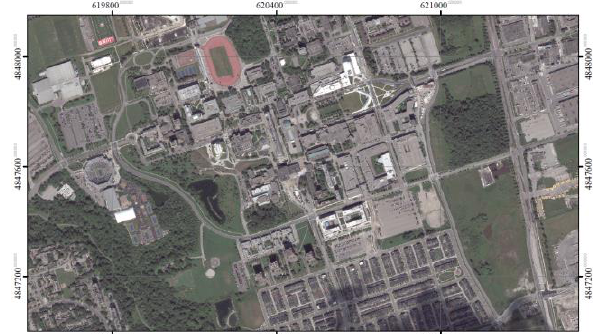
Figure 1: The true colour composite of the Worldview-3 imagery of the study area.